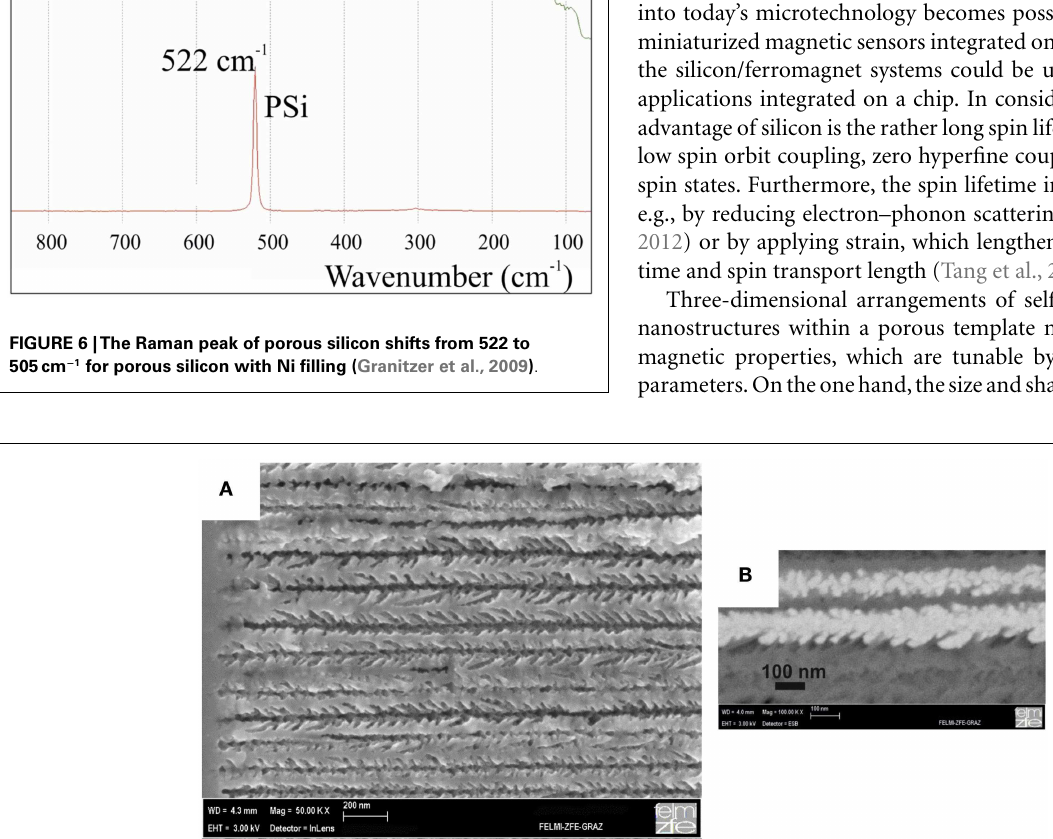
Frontiers in Materials | Optics and